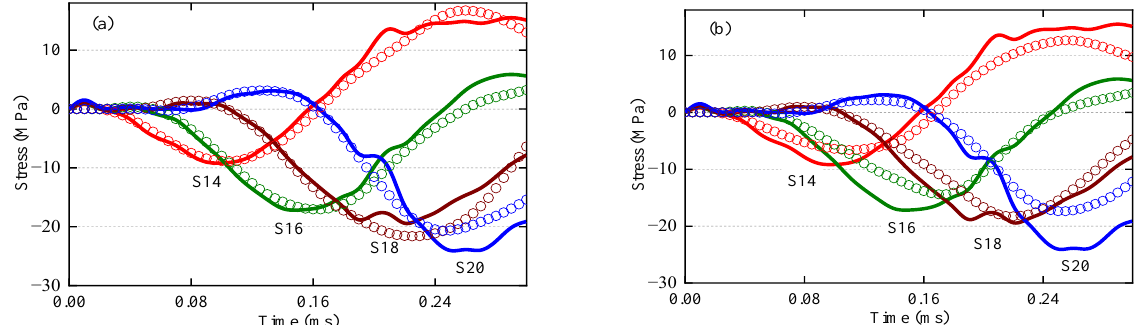
Figure 7. Stress responses of the first impact of H = 50 mm: ( a ) Experimental results (Solid line) and eigenfunction method results (Scatter) with Hertz model; ( b ) Experimental results (Solid line) and eigenfunction method results (Scatter) with MJG model.